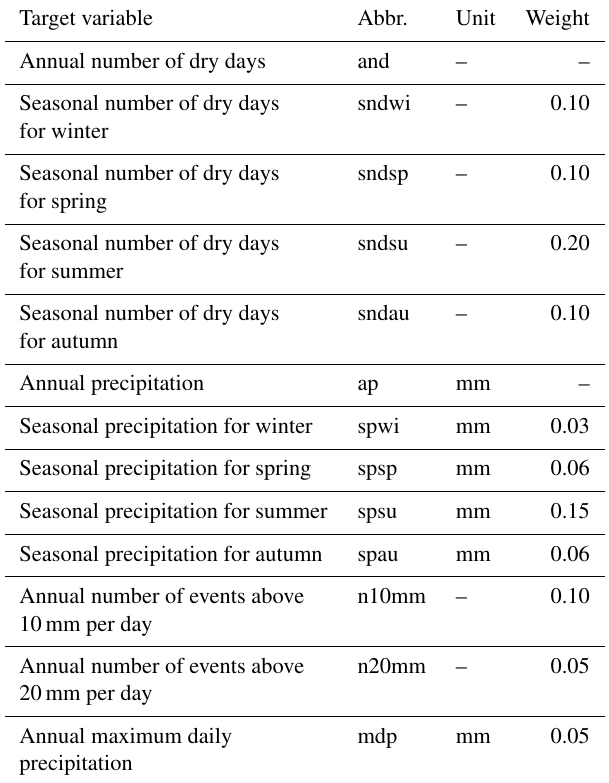
Table 2. Target variables used for evaluation of the simulations of WG.